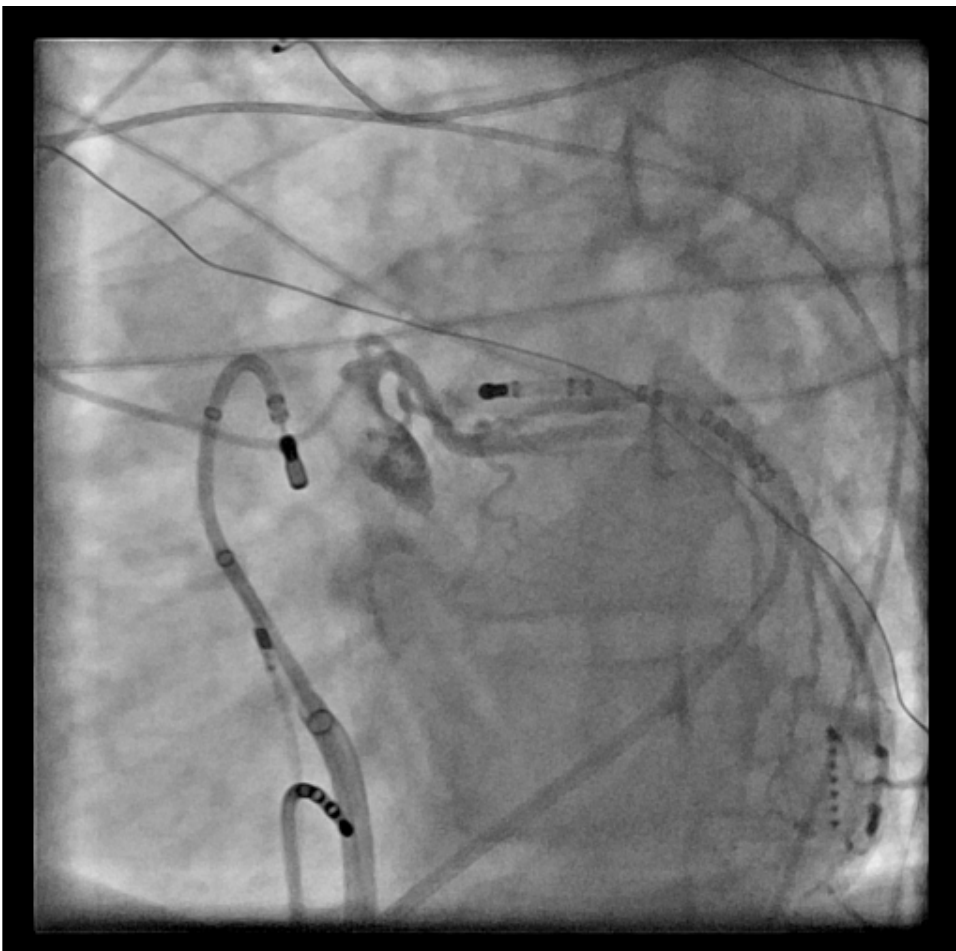
Figure 4. LAO view with ablation catheter in the RVOT retroflexed back onto the PV, and a left coronary angiogram showing the proximity to the catheter location.